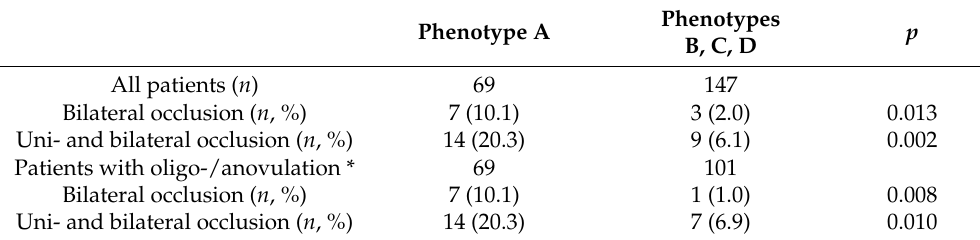
Table 4. The prevalence of Fallopian tube occlusion in women with polycystic ovary syndrome (PCOS) phenotype A versus women with PCOS phenotypes B, C, or